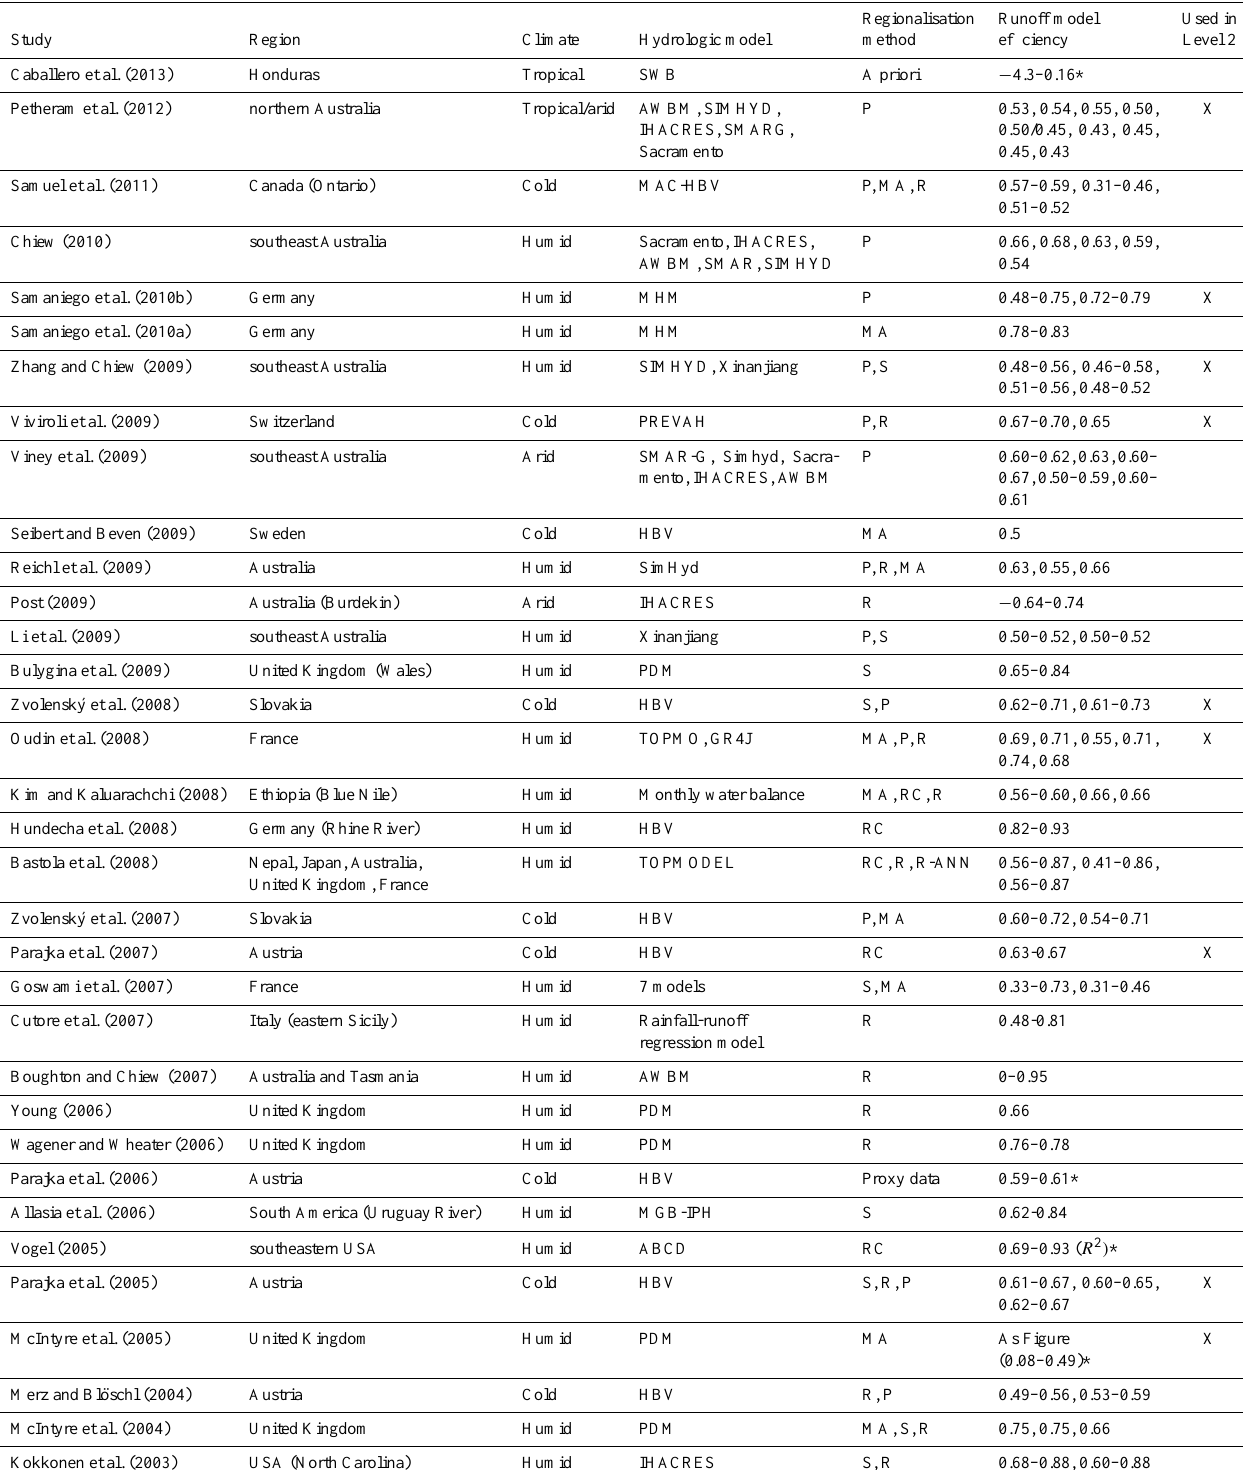
Table 1. Summary assessment of existing regionalization studies for continuous runoff simulation. Statistical evaluation indicates the leave- one-out assessment of runoff model efficiency. Methods used for transfer of hydrologic model parameters include: spatial proximity (P), similarity (S), model averaging (MA), parameter regression (R) and regional calibration